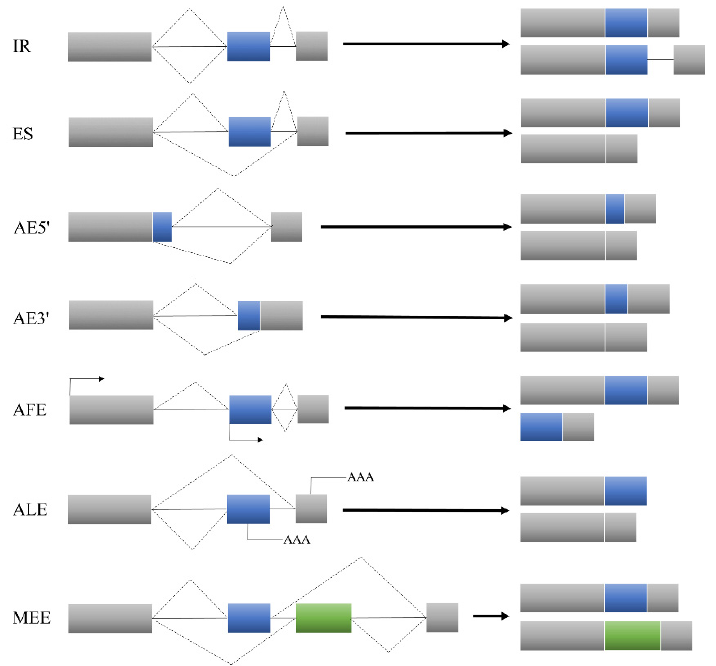
Figure 1. Alternative splicing